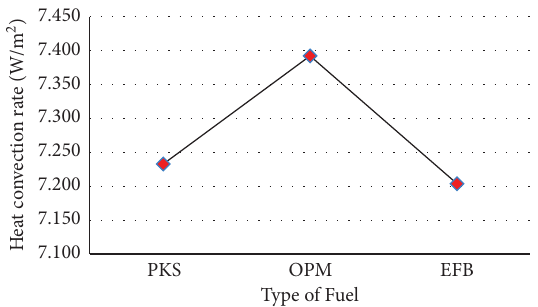
Figure 9: Heat convection rate for different fuels at the mea- surements (M-II).